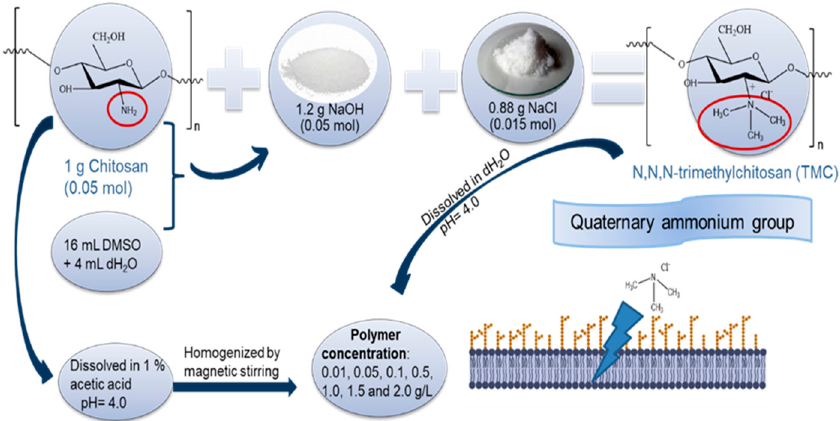
Figure 11. A schematic representation of the synthesis steps for the methylation process of the quaternization of the amino groups of chitosan resulted in N,N,N-trimethyl chitosan (TMC). To investigate the differences in the degree of deacetylation, commercial and natu- rally deacetylated chitosan were used for comparison. Stock solutions of chitosan and